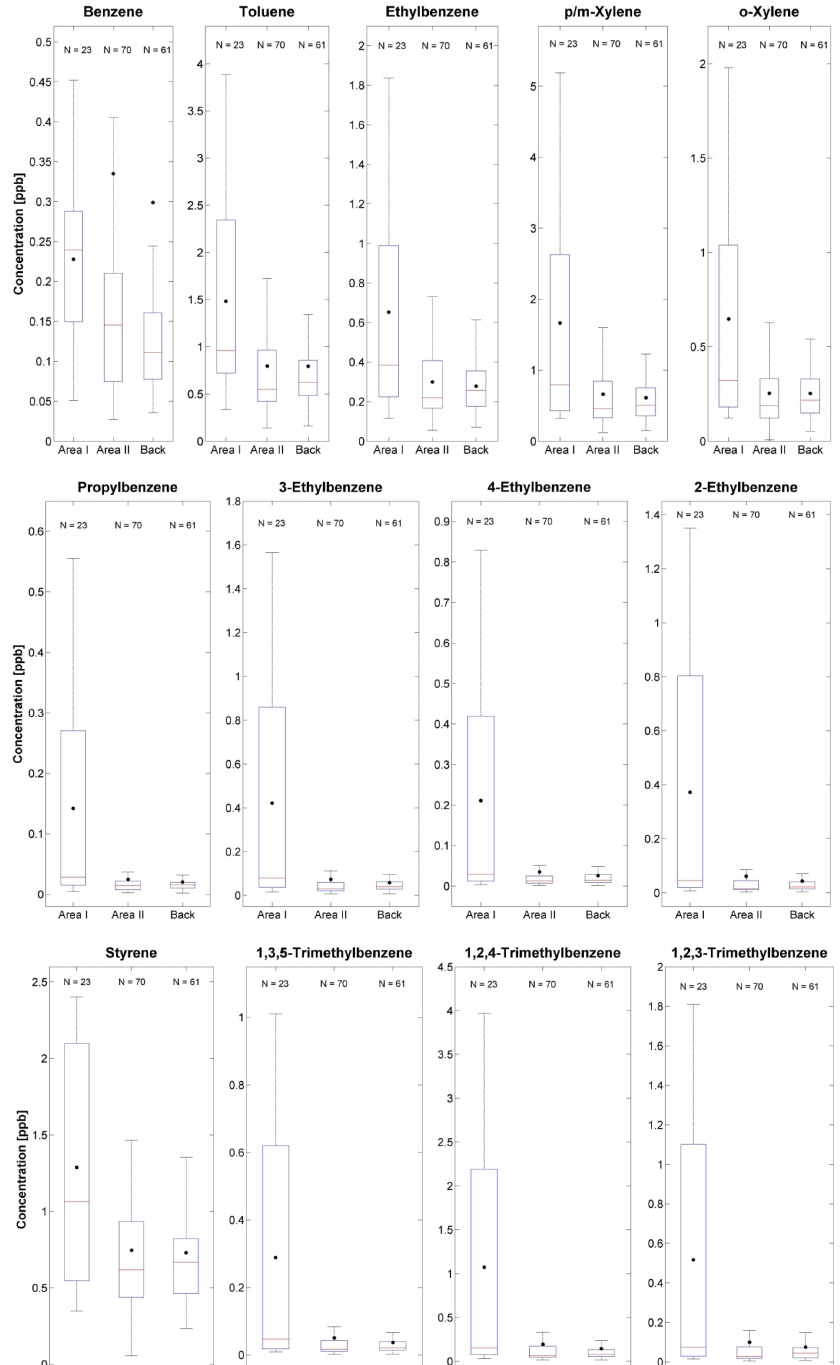
Figure 6. BTEX concentrations measured in air masses arriving at Welgegund, after they had passed over the defined source regions. The red line of each box indicates the median (50th percentile), the black dot the mean, the top and bottom edges of the box the 25th and 75th percentiles, and the whiskers ± 2.7 σ or 99.3% coverage if the data have a normal distribution (MATLAB, 2010). The values displayed near the top of the graphs indicate the number of samples (N) analysed for each source